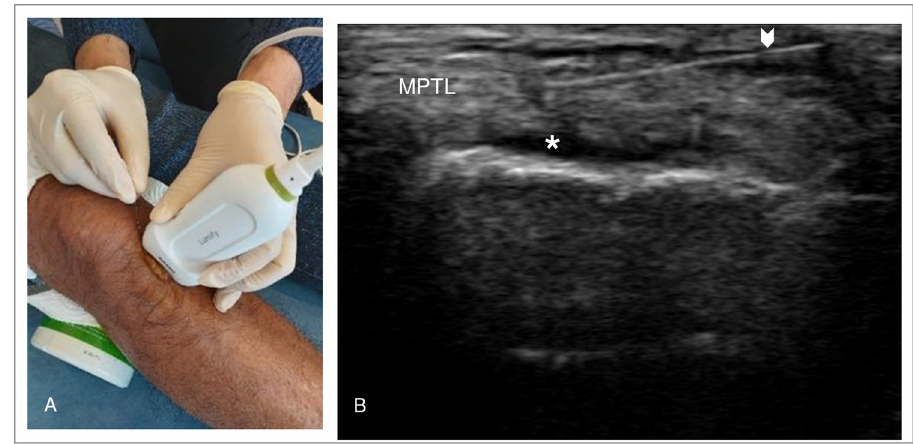
Fig 3. Application of US-guided DN in patients with mucoid degeneration of medial patellotibial ligament (MPTL). (A) Positioning of the DN and transducer in the application of US-guided DN; (B) Longitudinal view of the medial patellotibial ligament (MPTL) with hyperechoic change (white star � ). The needle with reverberation artifact was displayed by arrowhead.